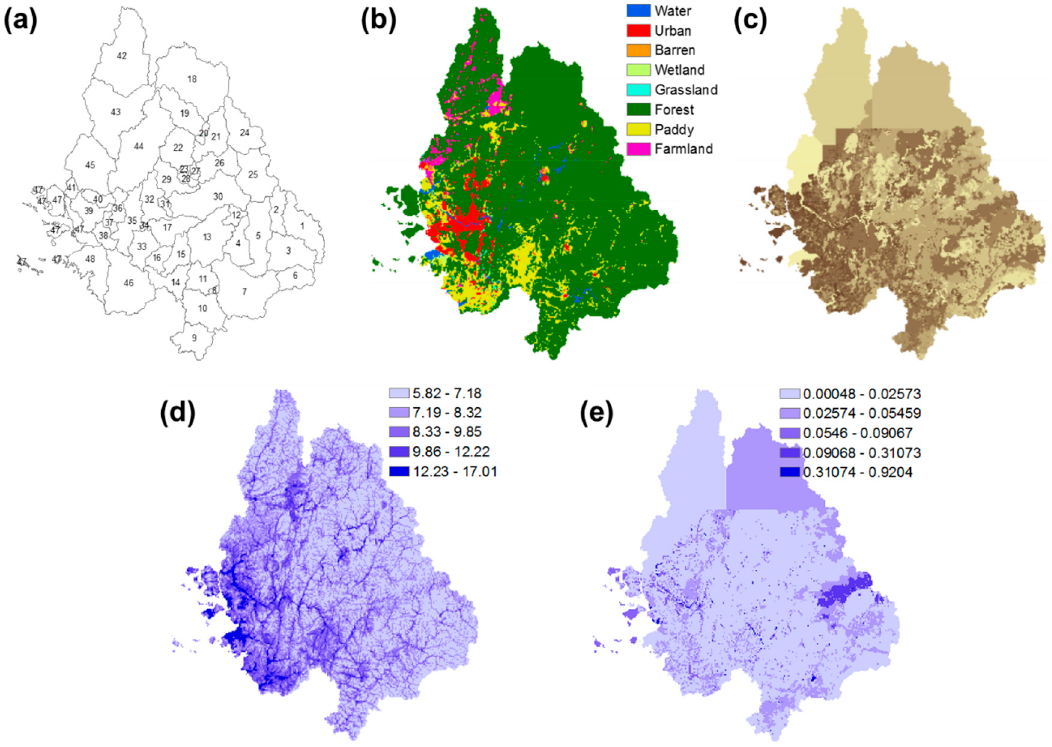
Figure 4. Topographical input data; ( a ) catchment with 48 sub-basins; ( b ) land cover classification; ( c ) soil type; ( d ) topographic index; and ( e ) transmissivity. Please note that there is no available information north of the DMZ line (Figure 2b) for soil type and transmissivity.